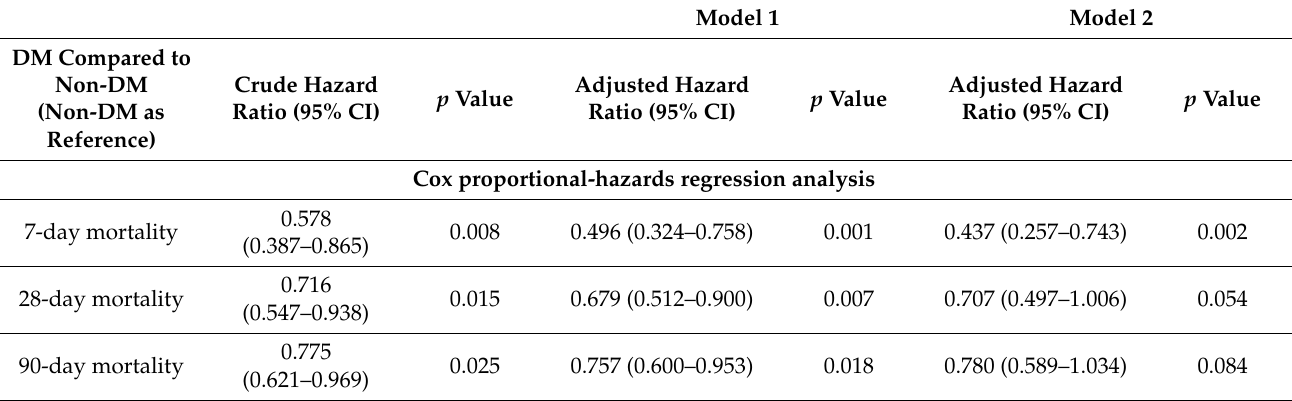
Table 2. Mortality comparisons between DM and non-DM groups for Cox proportional-hazards regression and logistical regression analysis in construction